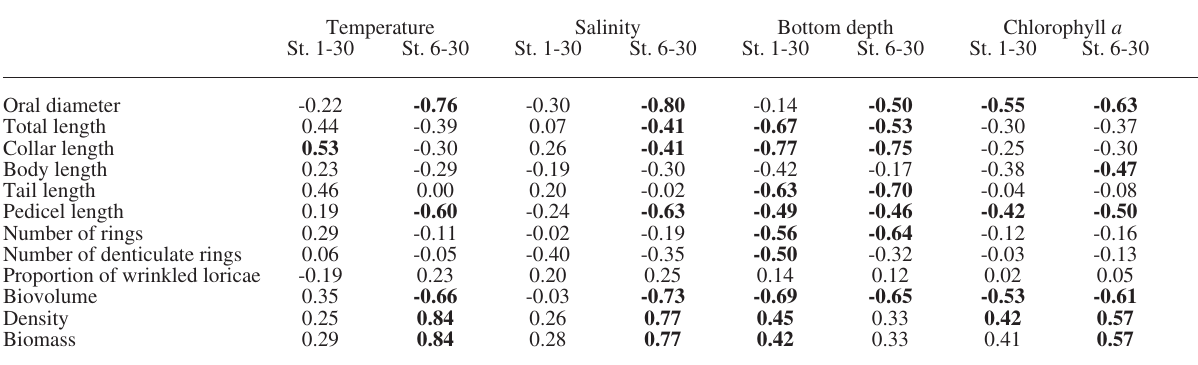
Table 3. – Spearman’s correlation coefficients between morphological parameters/abundance of Helicostomella and environmental variables. Significant correlations ( P <0.05) are denoted in bold. For St. 1-30, n (number of stations) = 30 for abundance values and n = 27 for